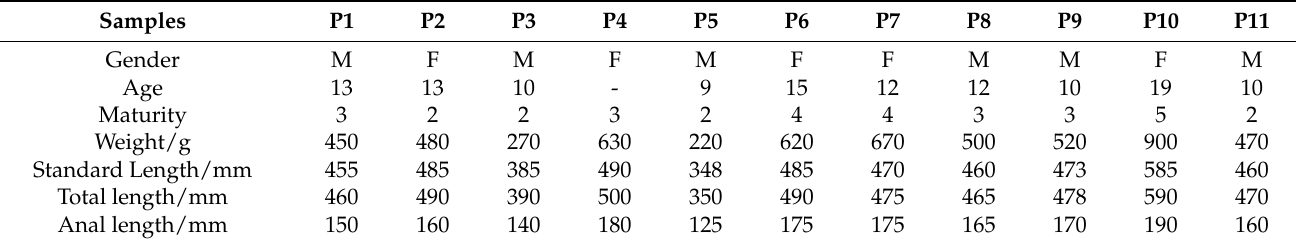
Table 3. Biological measurements of M. caml . M and F, respectively, refer to male and female individuals. P1 to P11 refers to sample 1 to sample 11.